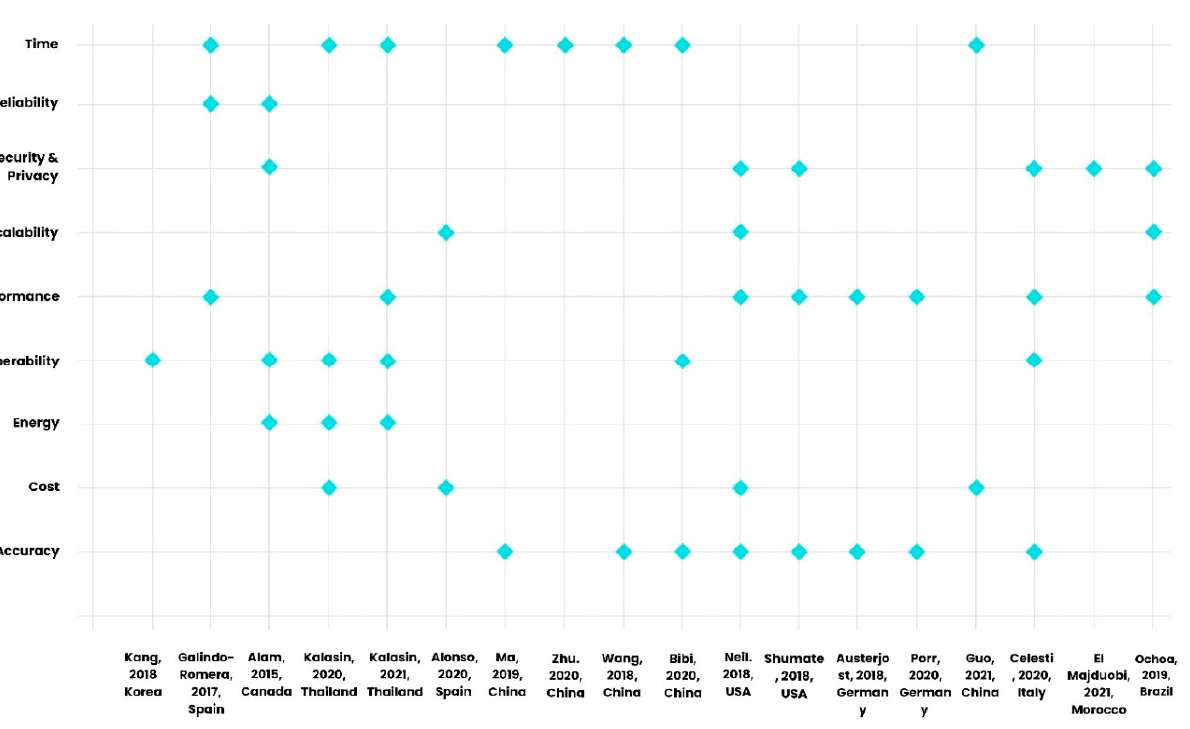
Figure 9. Advantages of IoT technologies from primary studies based on key metrics defined in Section 1.4, depicted in a scatter plot [56–73].